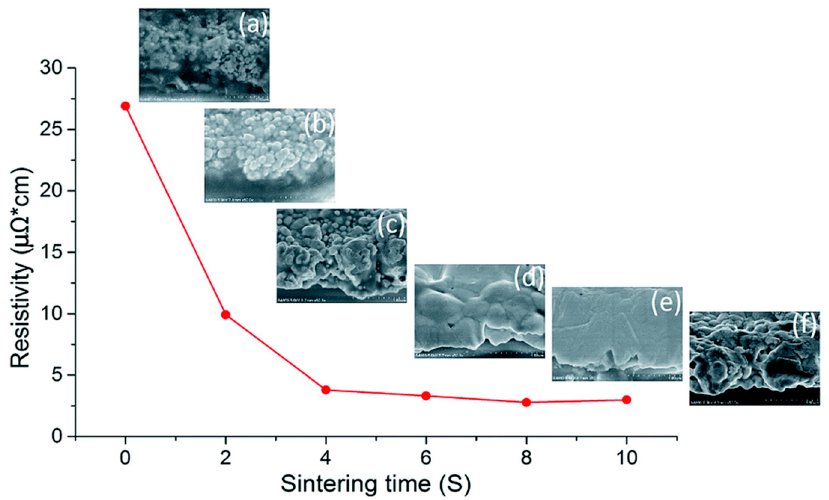
Figure 6. The resistivity of Ag NPs film sintered by NIR with power of 360 kW · m2 over 10 s and SEM images of the sintered film at ( a ) 0 s; ( b ) 2 s; ( c ) 4 s; ( d ) 6 s; ( e ) 8 s,;and ( f ) 10 s. Reproduced with permission from [80]; Copyright 2018 Royal Society of Chemistry.